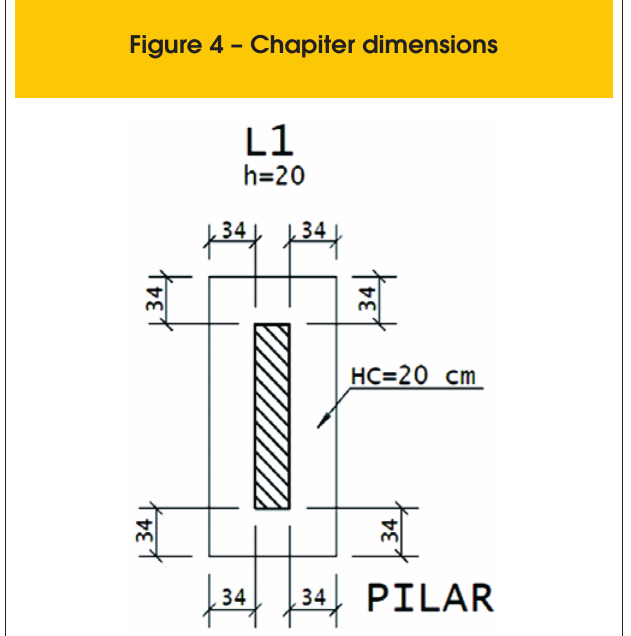
Figure 4 – Chapiter